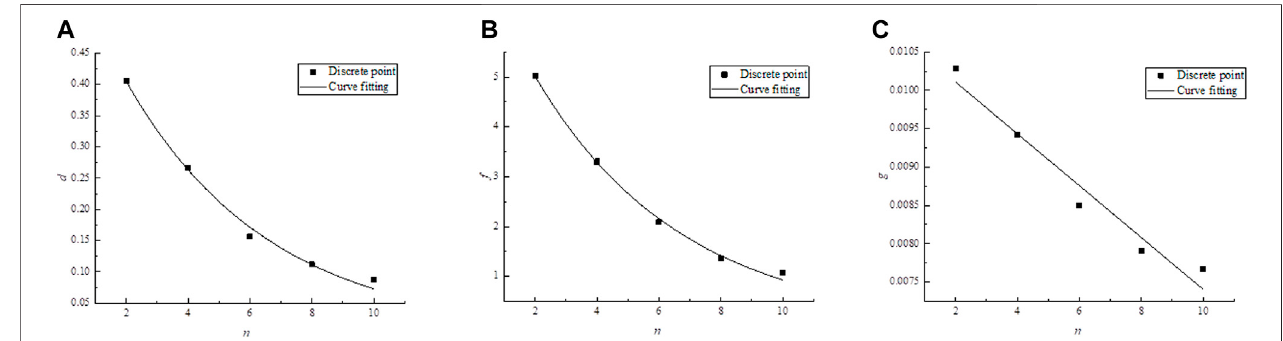
FIGURE 6 | Fitting curve diagram of parameter. (A) parameter d, (B) parameter f, (C) parameter g.